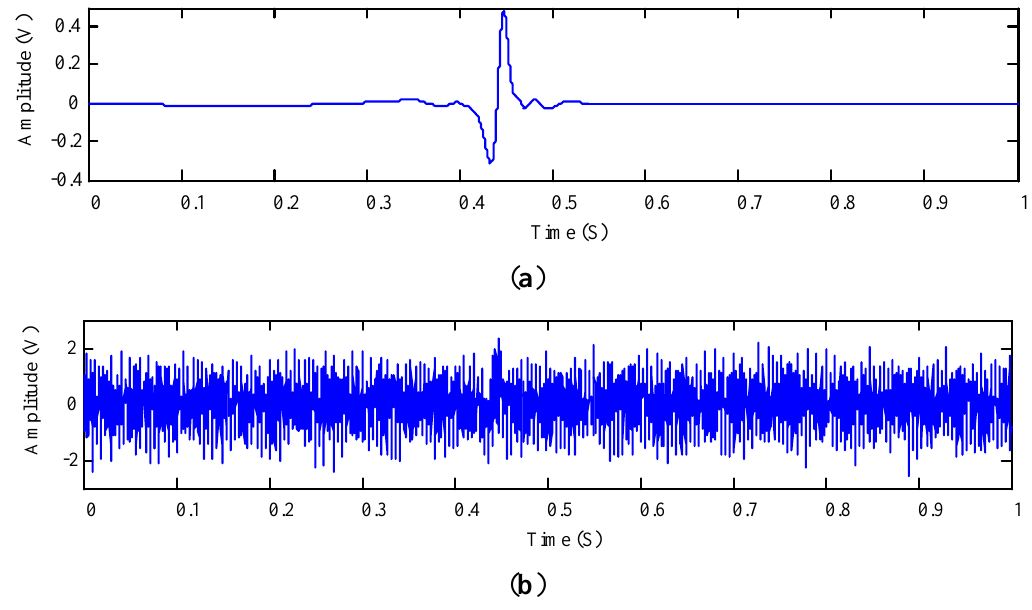
Figure 13. Extraction of the 508 μm aluminum particle signature using the